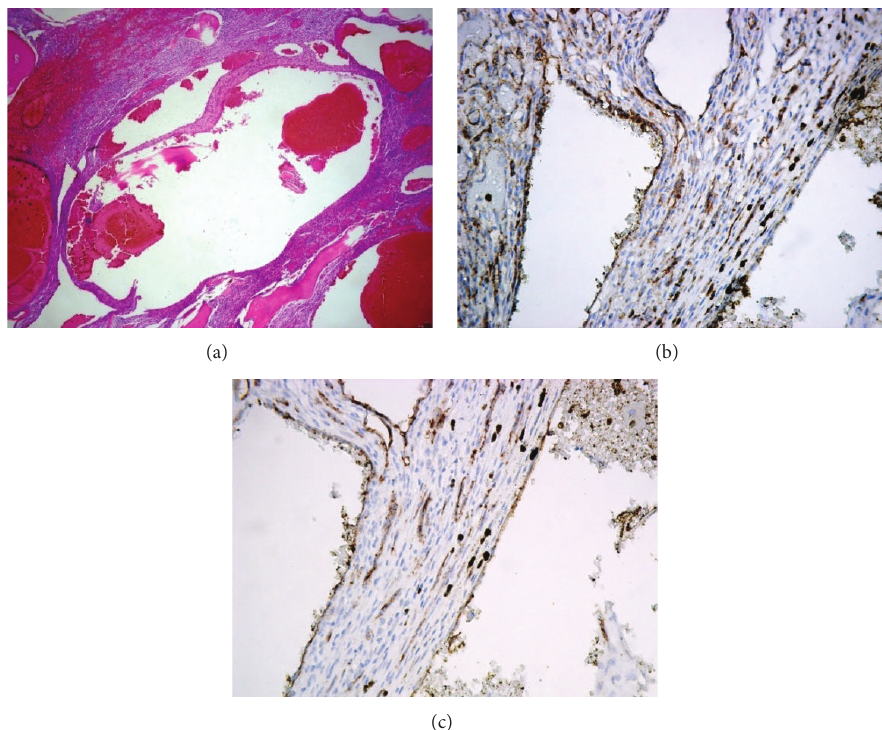
Figure 5: Immunohistological staining of the surgical specimen. (a) Staining of hematoxylin and eosin ( × 100), (b) CD31 ( × 400), and (c) CD34 ( × 400).